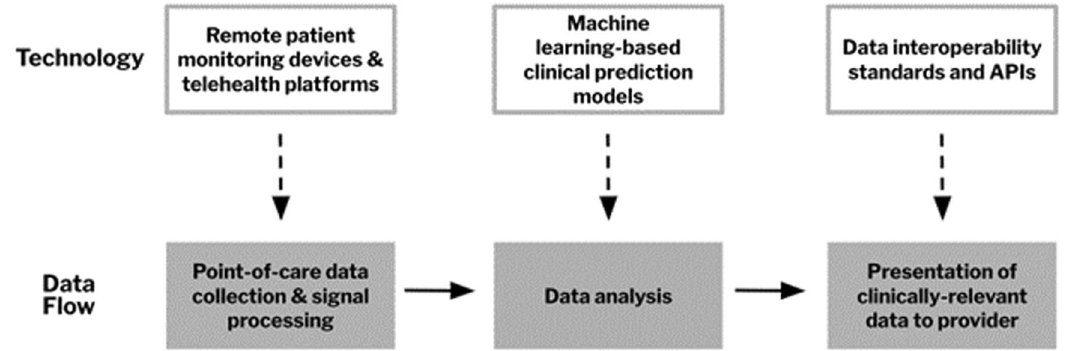
Fig. 1 Data fl ow in a surgical home hospital (SHH) program. Technologies like remote patient monitoring and risk prediction models play roles in data fl